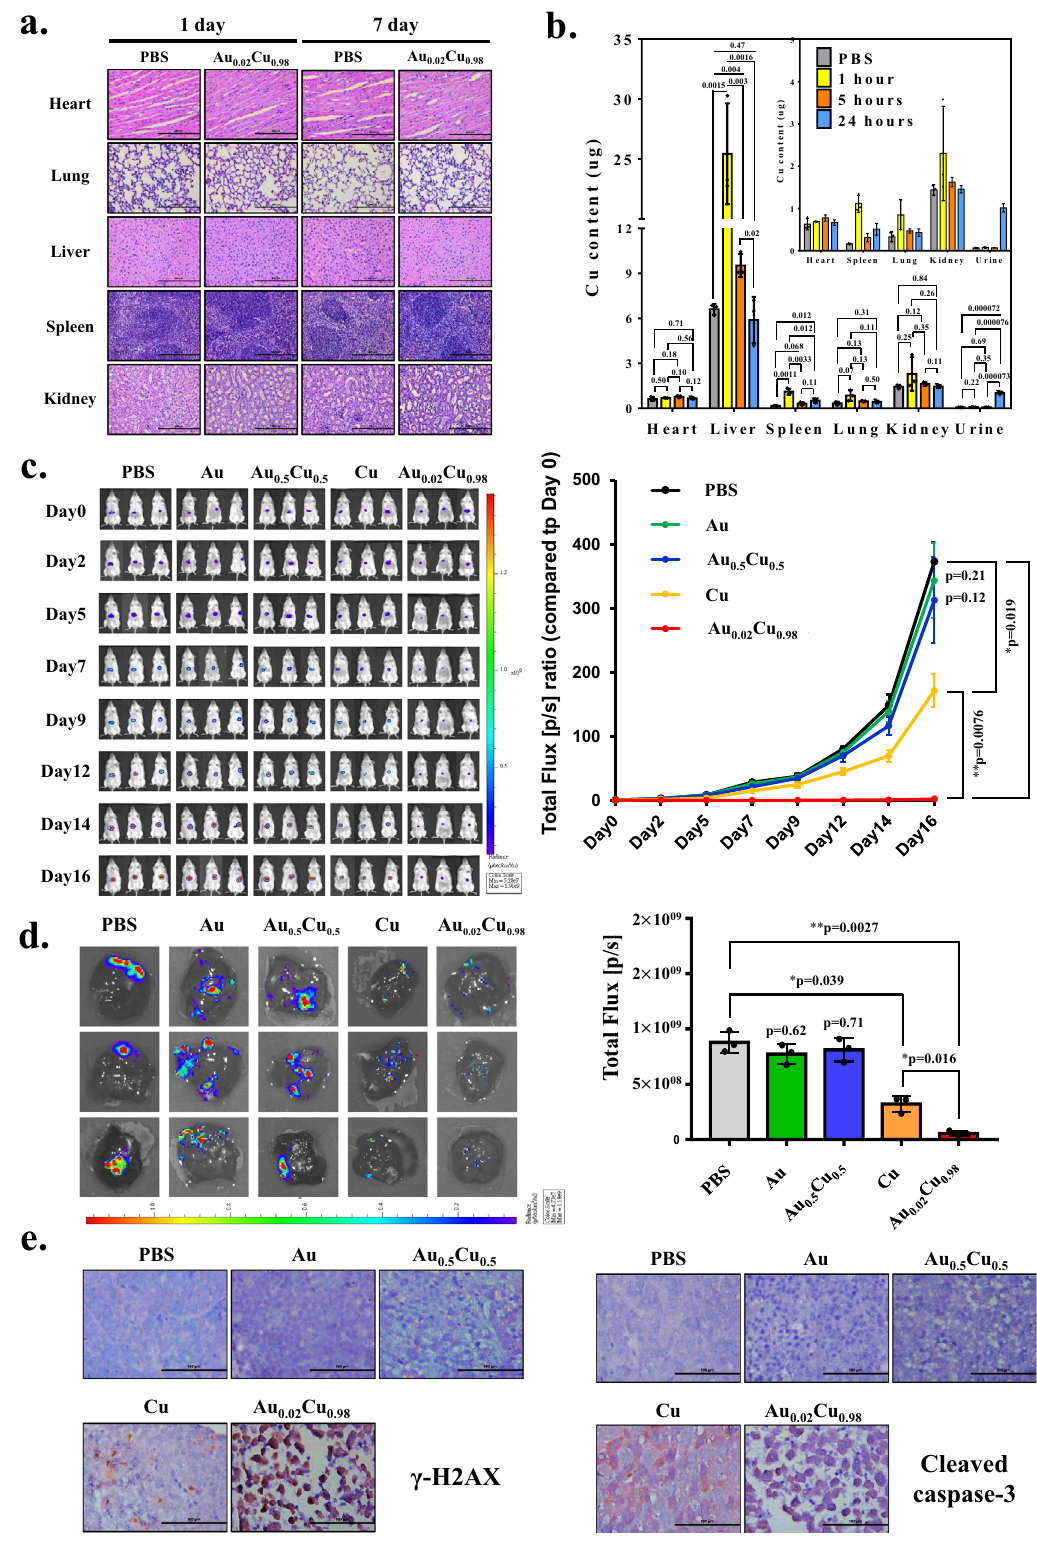
were seeded in 96-well plates (8000 cells/per well) and incubated for 24 h, followed by the treatments of medium alone (blank) or 100 ppm of Au/Cu 0 nanocubes for another 24 h. After treatments, the cells were gently rinsed twice and further stained by PI and Calein-AM following the standard process. The distribution of dead and live cells was observed by laser scanning confocal